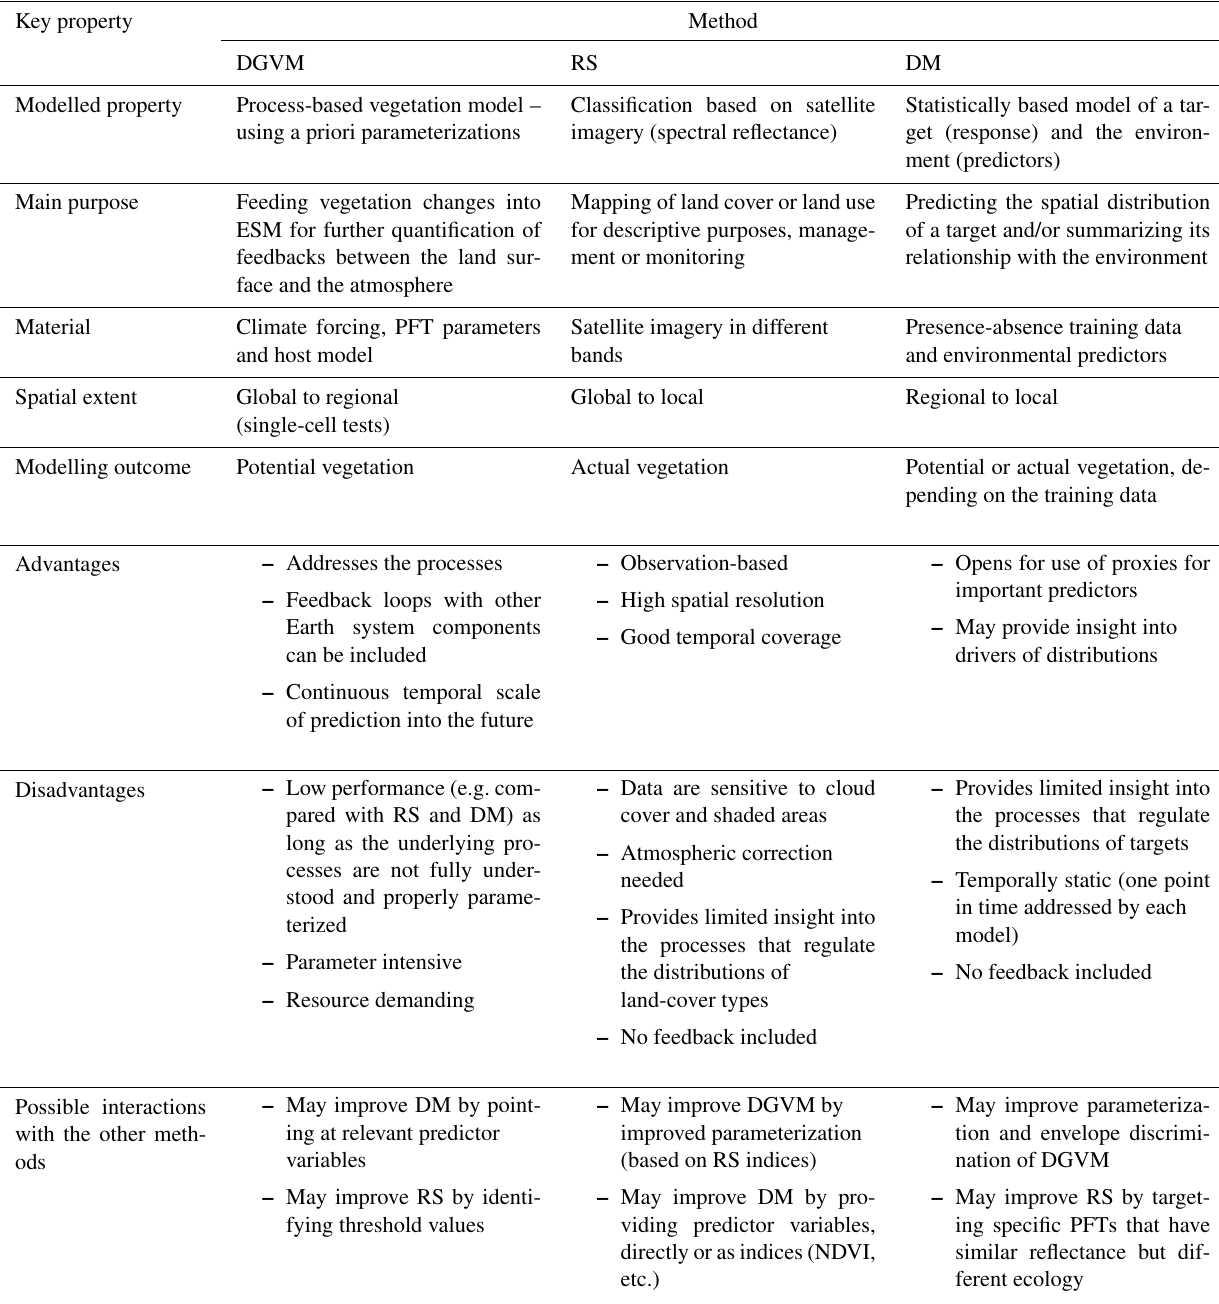
Table 4. A summary of the key properties of the three methods compared in this study. DGVM – dynamic global vegetation model, RS – remote sensing and DM – distribution